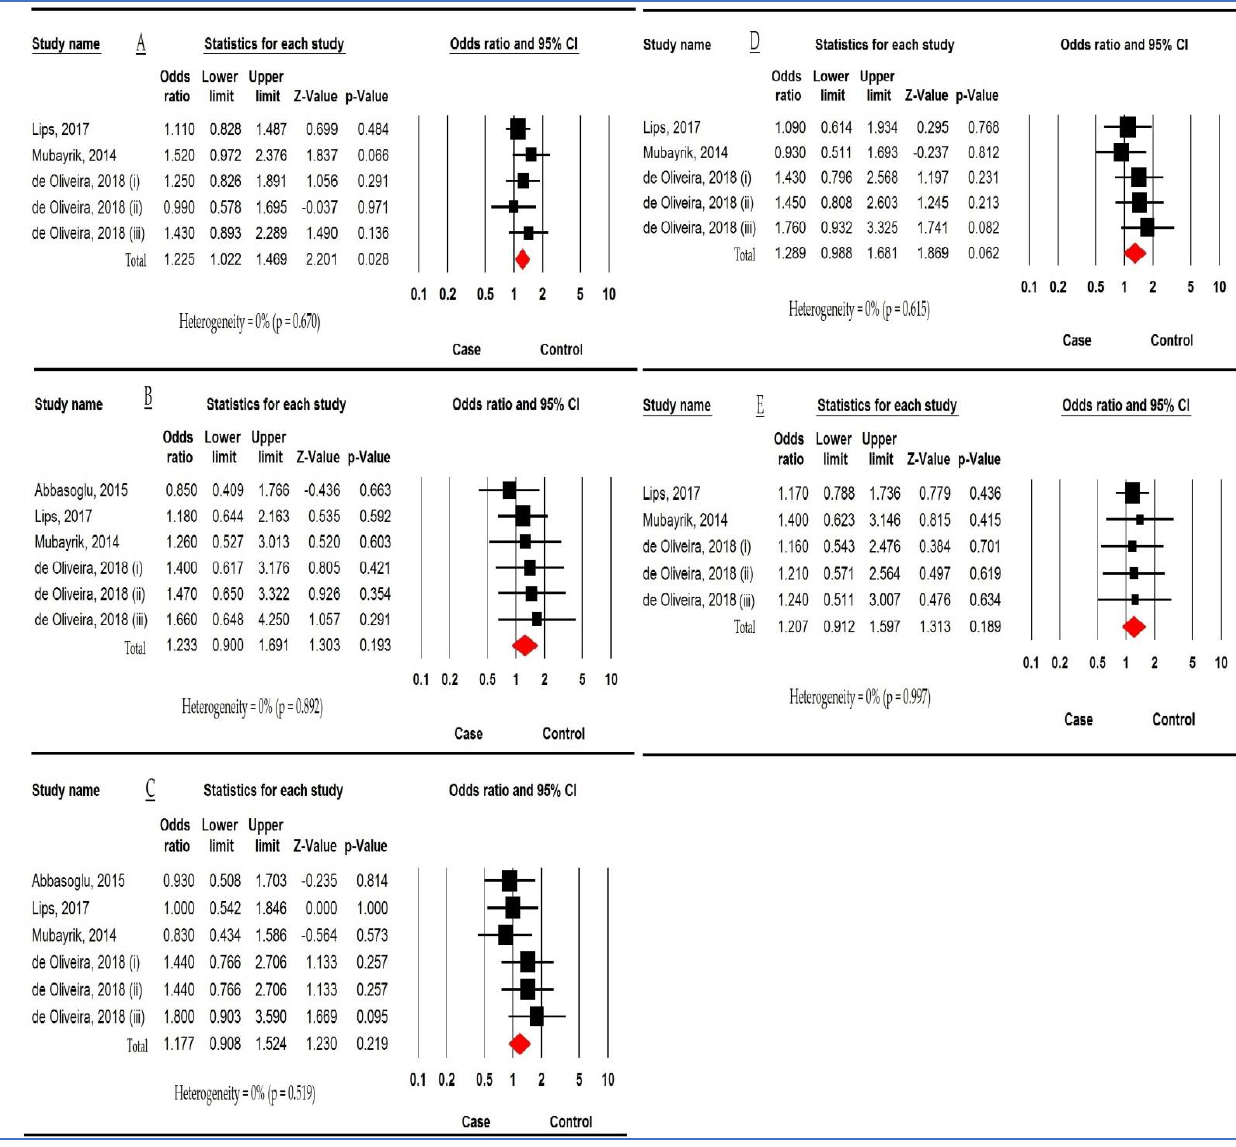
Figure 2. Forest plot showing the association between defensin beta 1 (DEFB1) rs11362 polymor- phism and dental caries risk. ( A ) Allelic model. ( B ) Homozygous model. ( C ) Heterozygous model. ( D ) Dominant model. ( E ) Recessive model. ((i) Deciduous dentition. (ii) Permanent